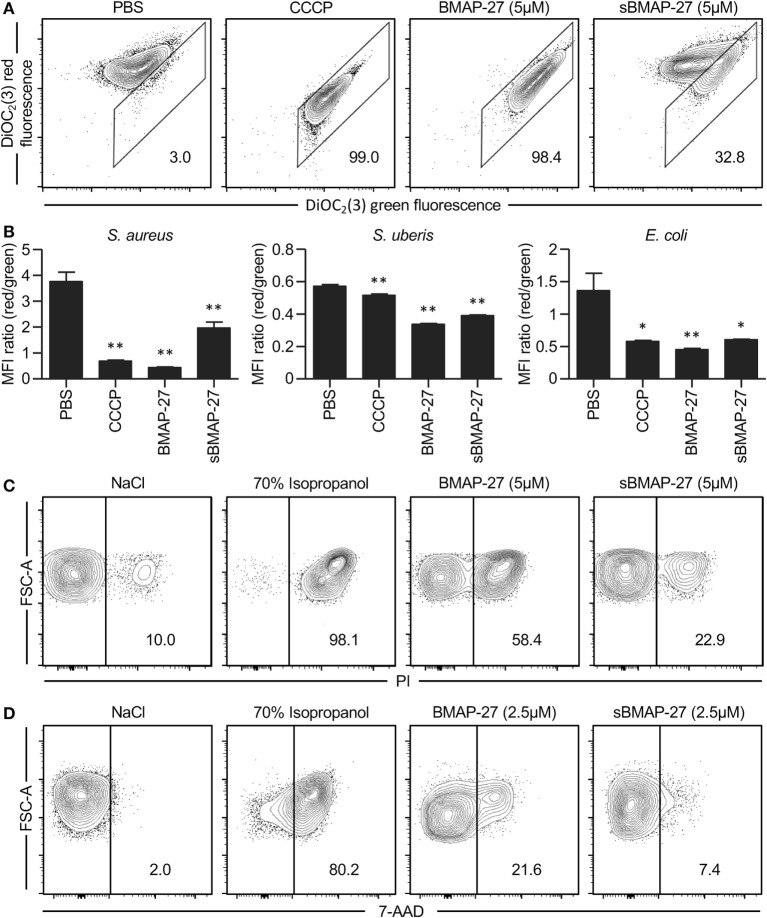
Impact of bovine myeloid antimicrobial peptide (BMAP)-27 on bacterial membrane integrity. (A) 107 CFU of Staphylococcus aureus M3842 were incubated with 5 µM of BMAP-27 or sBMAP-27 together with the carbocyanine dye DiOC2(3) for 30 min to measure membrane potential. A shift from red to green fluorescence indicates a loss of membrane potential. The protonophore CCCP (5 µM) was employed as positive control. Plots are shown from a representative experiment out of three. (B) Ratio of red/green fluorescence determined for S. aureus M3842, Streptococcus uberis M100/11, or Escherichia coli 9217/10 incubated with BMAP-27 (5 µM), sBMAP-27 (5 µM), CCCP (5 µM), or PBS. Bar represents the mean fluorescence intensity ratio ± SD of triplicate cultures. Significant differences compared to the untreated control were determined by Dunnett’s multiple comparison tests (*p < 0.05; **p < 0.01). (C)
S. aureus membrane permeabilization by BMAP-27. A total of 107 CFU of S. aureus M3842 were incubated at the indicated concentration of cathelicidin for 1 h, washed, and then stained with propidium iodide (PI). Flow cytometry plots of one representative experiment out of two are presented and frequencies of PI-positive cells indicated. (D) E. coli membrane permeabilization by BMAP-27. A total of 107 CFU of E. coli 9217/10 were incubated at the indicated concentrations of cathelicidin for 1 h and stained with 7-aminoactinomycin D (7-AAD). Plots of one representative experiment out of two are shown with frequency representing 7-AAD positive cells. Doublets and bacterial cell debris based on the different FSC and SSC parameters were excluded in all experiments.